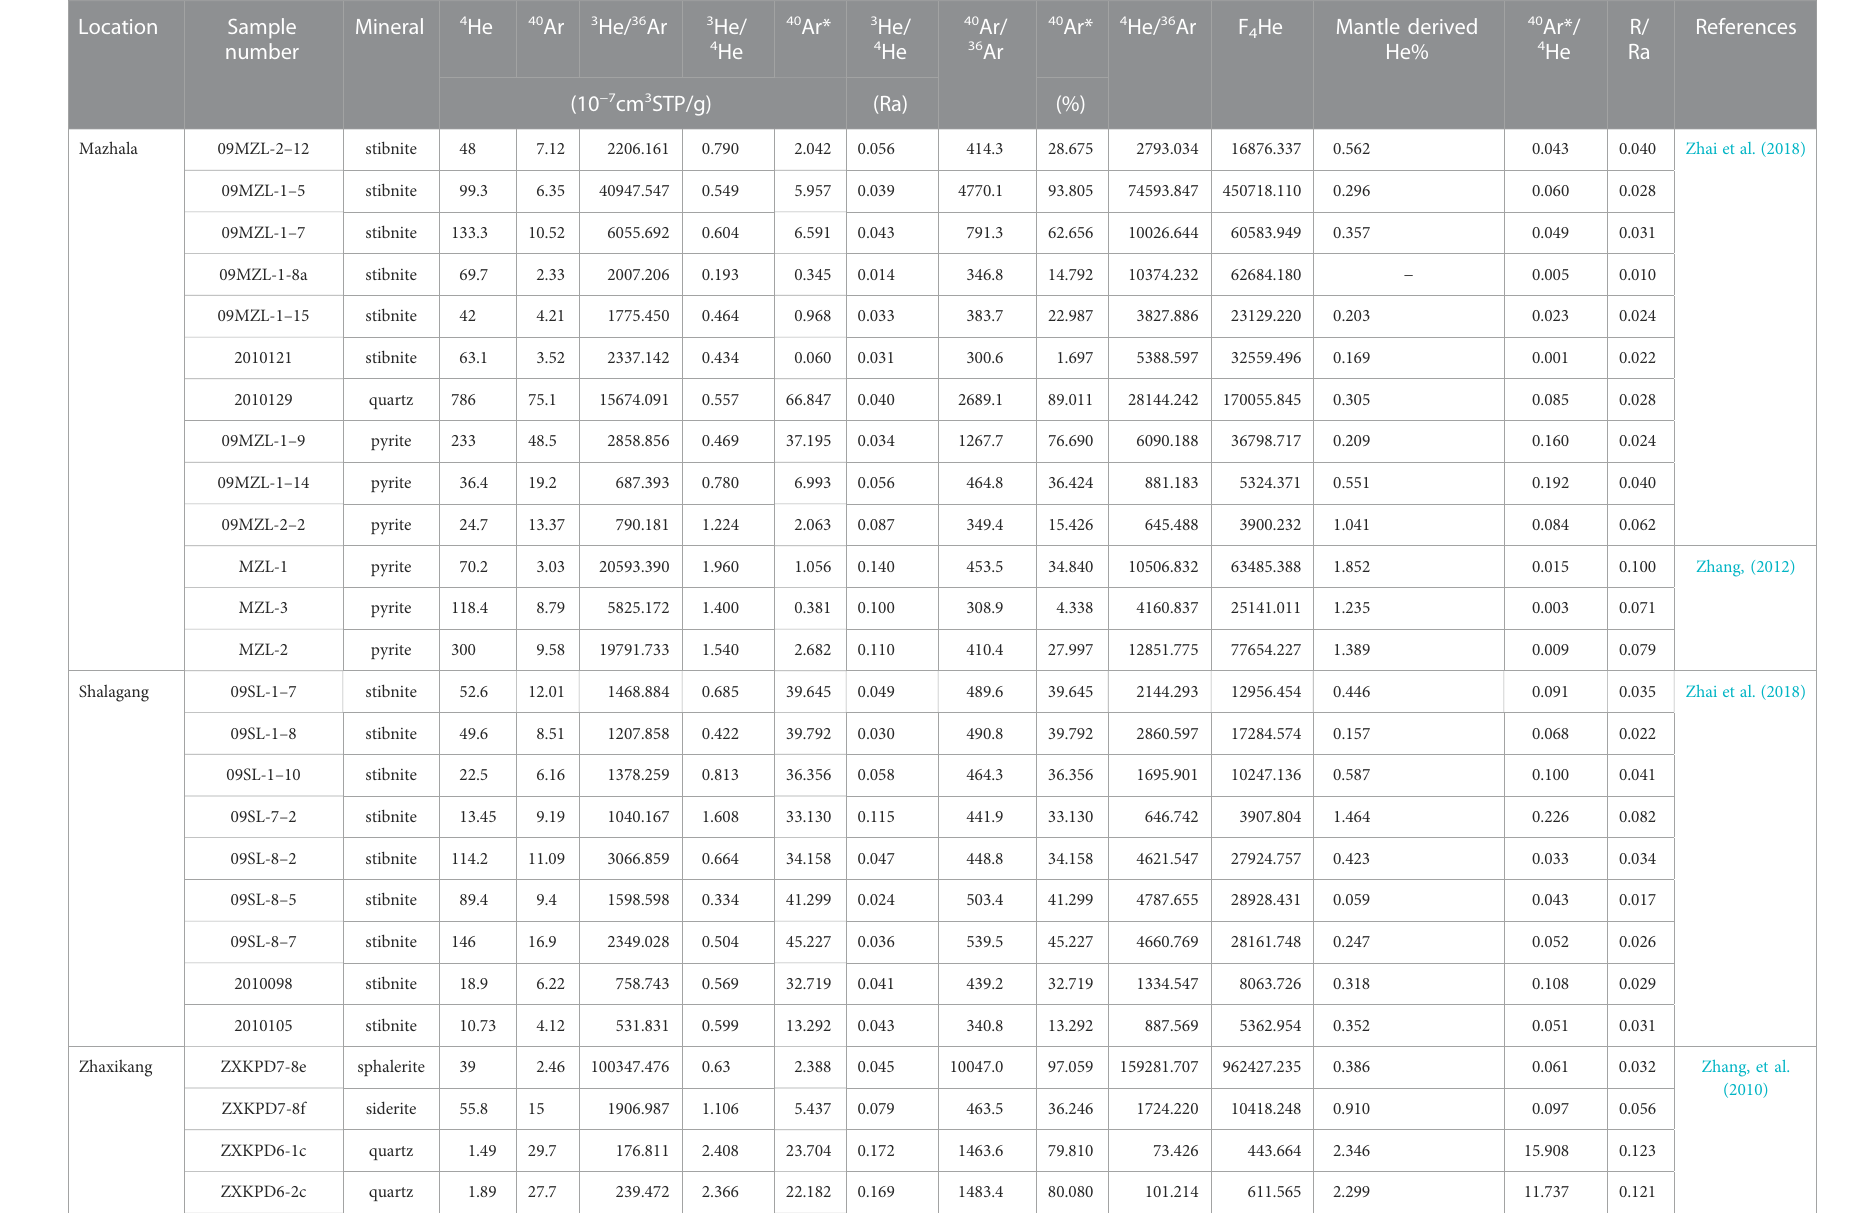
TABLE 2 He and Ar isotopic compositions of fl uid inclusions of typical antimony polymetallic deposits in the Tethys Himalaya metallogenic belt.